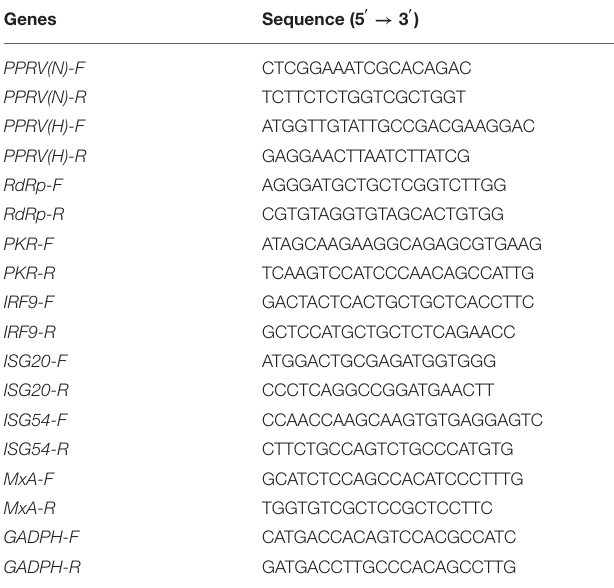
TABLE 1 | Sequences of primers used for